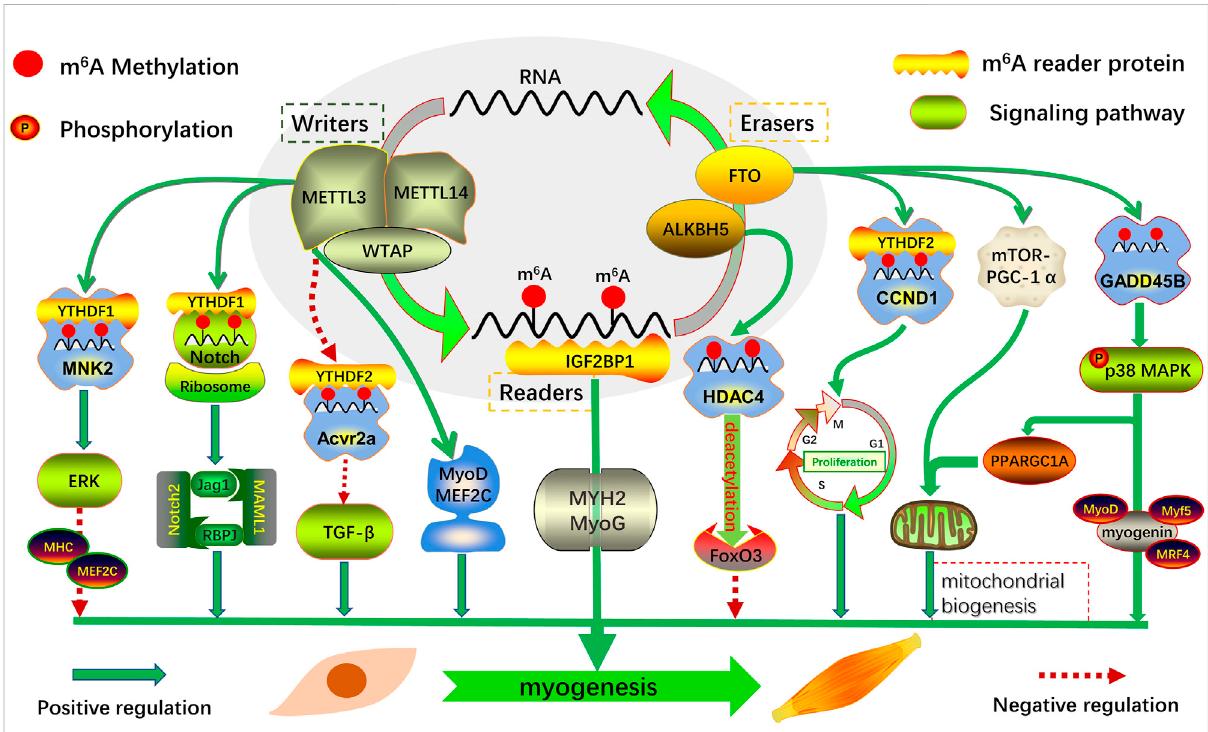
FIGURE 2 Regulatory role of m 6 A modi fi cation and its regulators in skeletal muscle myogenesis. Myogenic genes that mediate myogenesis are regulated transcriptionallyandpost-transcriptionallybym 6 A-relatedproteinsinmultipleways:regulatingthetranscriptionofkeyfactorsinanm 6 A-dependent manner; directly regulating the expression of related transcription factors; and coordinating with other transcription factors or post-transcriptional modi fi